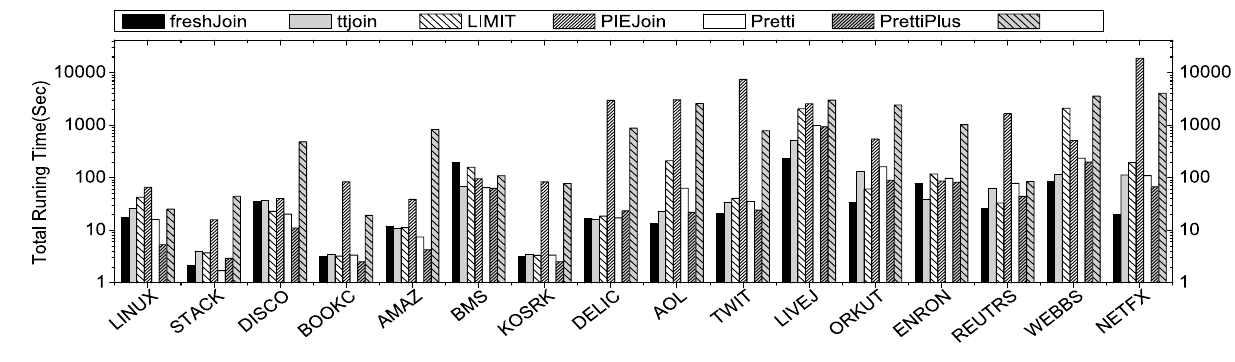
Fig. 7 The total running time of different